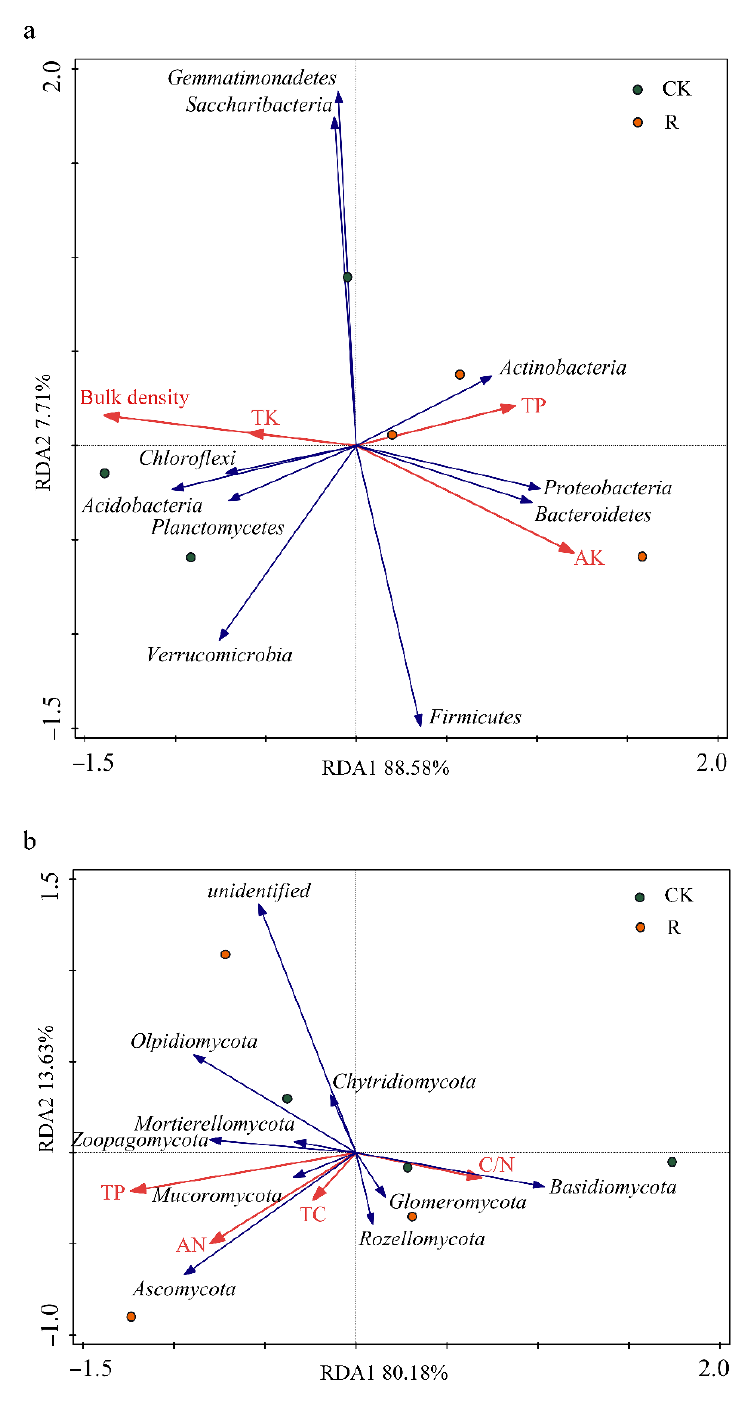
Figure 4. Redundancy analysis (RDA) between fungal communities and physicochemical charac- teristics at the 6 th pre-returning stage (( a ) for bacteria, ( b ) for fungi). CK, the non-vegetable residue treatment; R, the vegetable residue treatment.